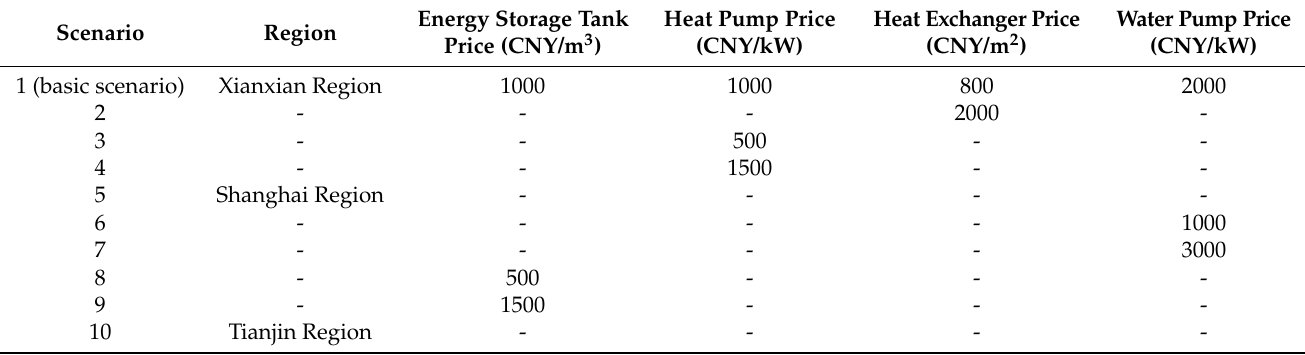
Table 2. Parameters used for optimization under 10 scenarios.